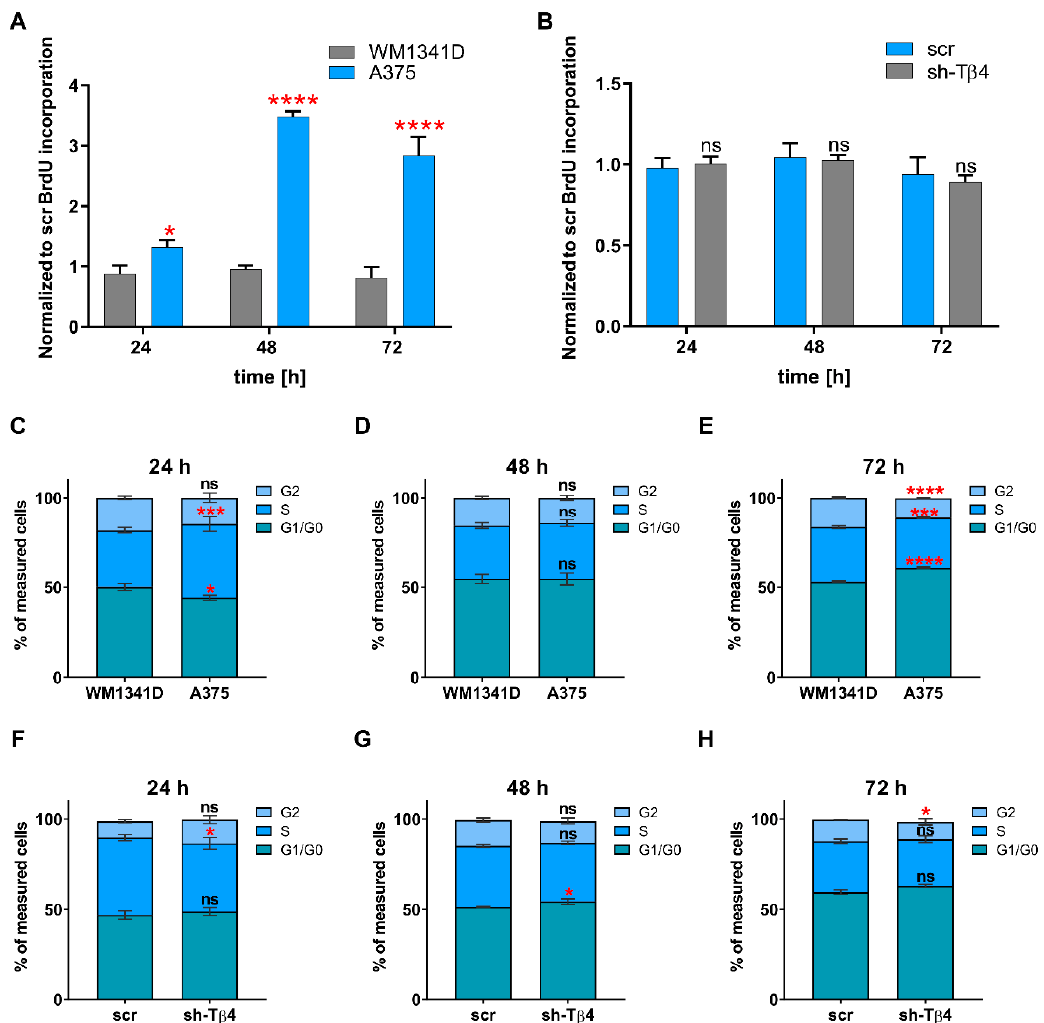
Figure 4. Analysis of cell proliferation rate and cell cycle progression in tested melanoma cells and evaluating the effect of TMSB4X expression silencing on these parameters. ( A , B ) Cell proliferation was measured using the BrdU assay 24, 48, and 72 h after seeding the cells ( n = 3): ( A ) WM1341D and A375 cells ( B ) scr and sh-T β 4 clones. The graphs indicate the mean ± SD. The results presented separately for every clone are shown in Supplementary Figure S7. ( C – H ) Flow cytometric analysis of cell cycle with propidium iodide DNA staining ( n = 3). ( C – E ) Analysis of the cell cycle was performed on WM1341D, and A375 cells collected, respectively, 24, 48, and 72 h after seeding. ( F – H ) Analysis of the cell cycle was performed on scr and sh-T β 4 cells collected 24, 48, and 72 h after seeding, respectively. The graphs indicate the mean ± SD. The results presented separately for every clone are shown in Supplementary Figure S8. The significance level was set at * p < 0.05, *** p < 0.001, and **** p < 0.0001.